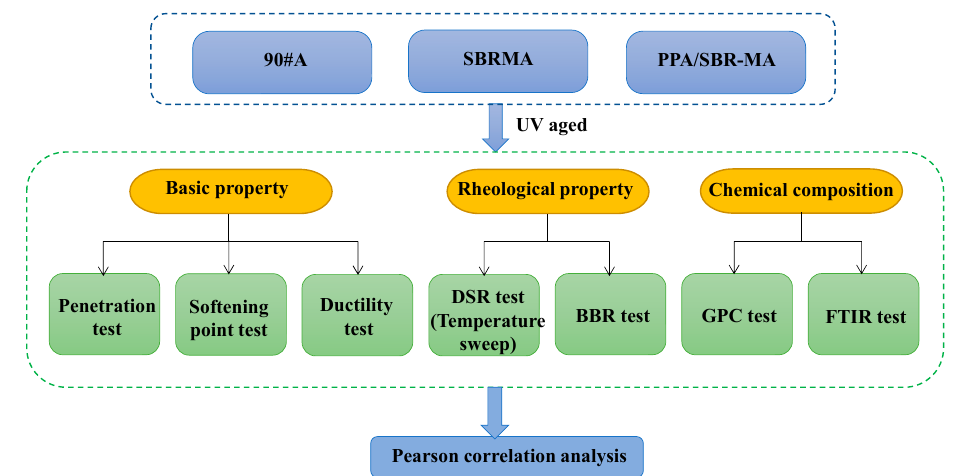
Figure 1. The designed process of experimental program.